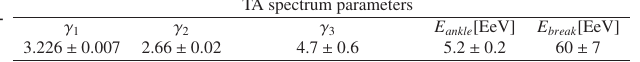
Table 1: Values of the broken power-law fit parameters for